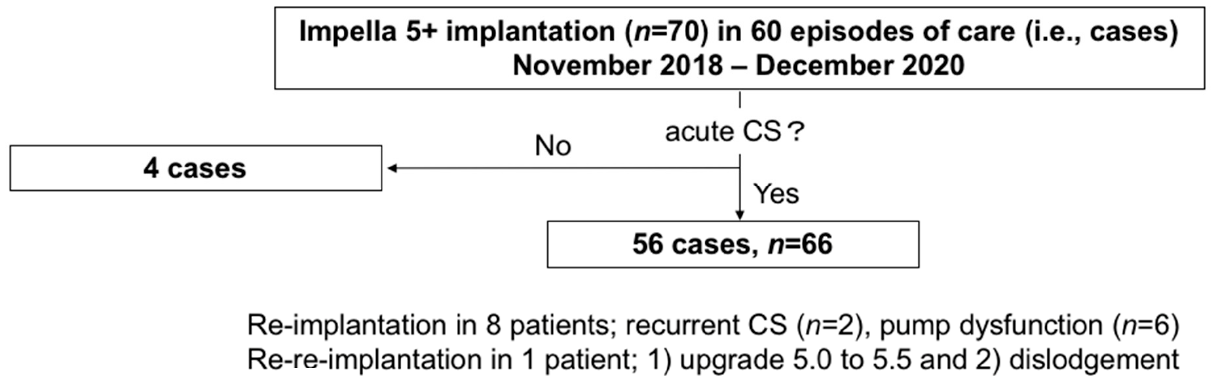
Figure 1. The graphic explanation of the study population. 66 applications in 56 episodes of care (i.e., cases), arising from 70 Impella 5+ (5.0 or 5.5) implantation in 60 cases. CS, cardiogenic shock; Impella 5+, Impella 5.0 or